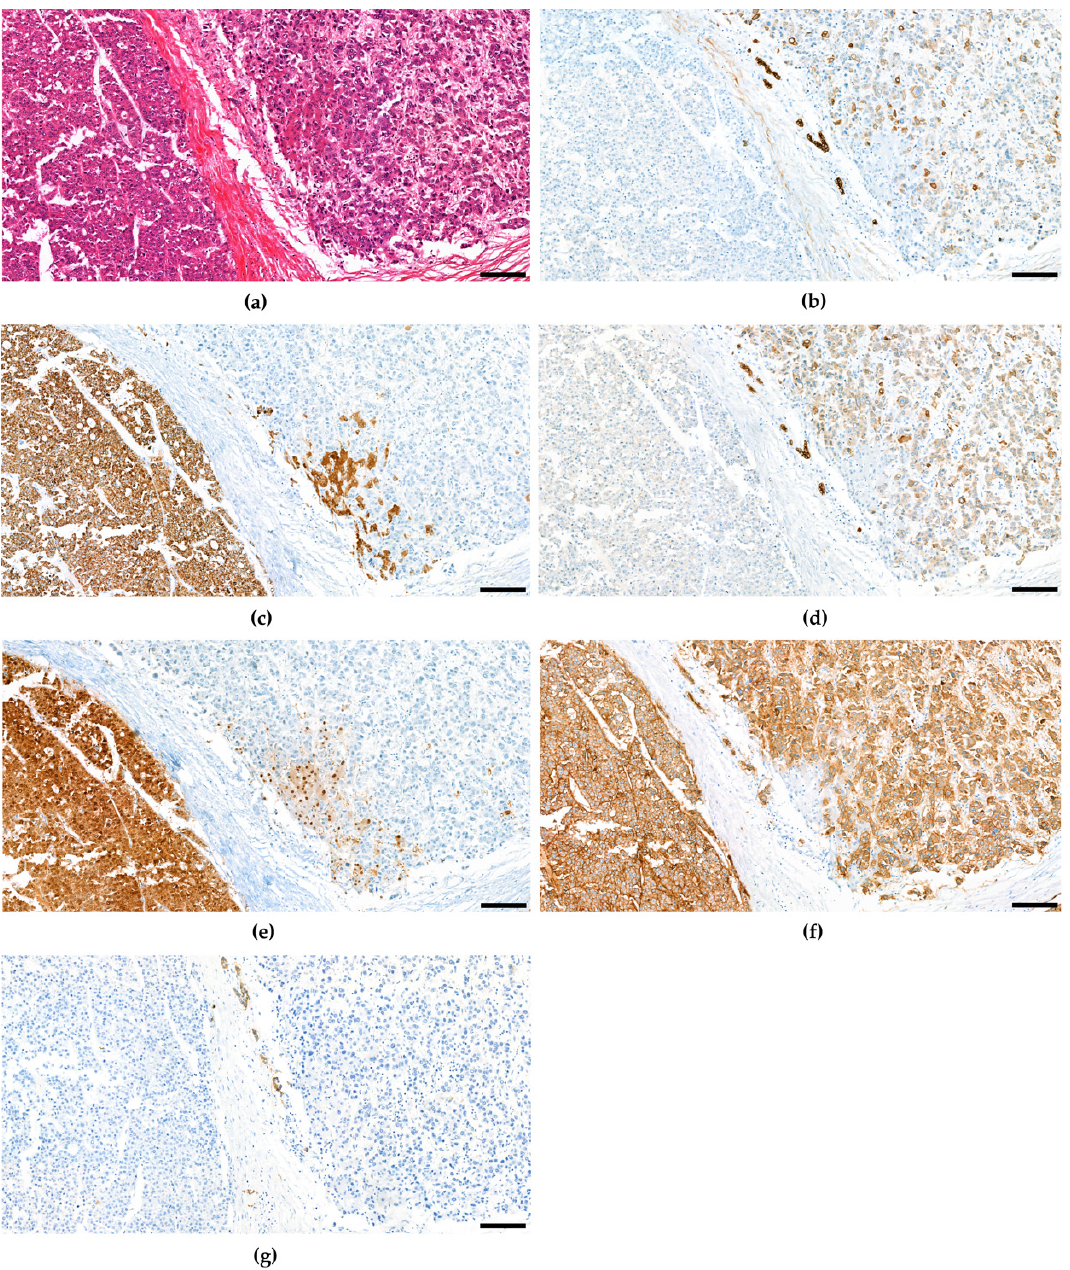
Figure 2. Combined hepatocellular and cholangiocellular carcinoma with distinct hepatocellular (left) and cholangiocellular (right) differentiated tumor components. ( a ) H&E. ( b ) CK7. ( c ) HepPar1.